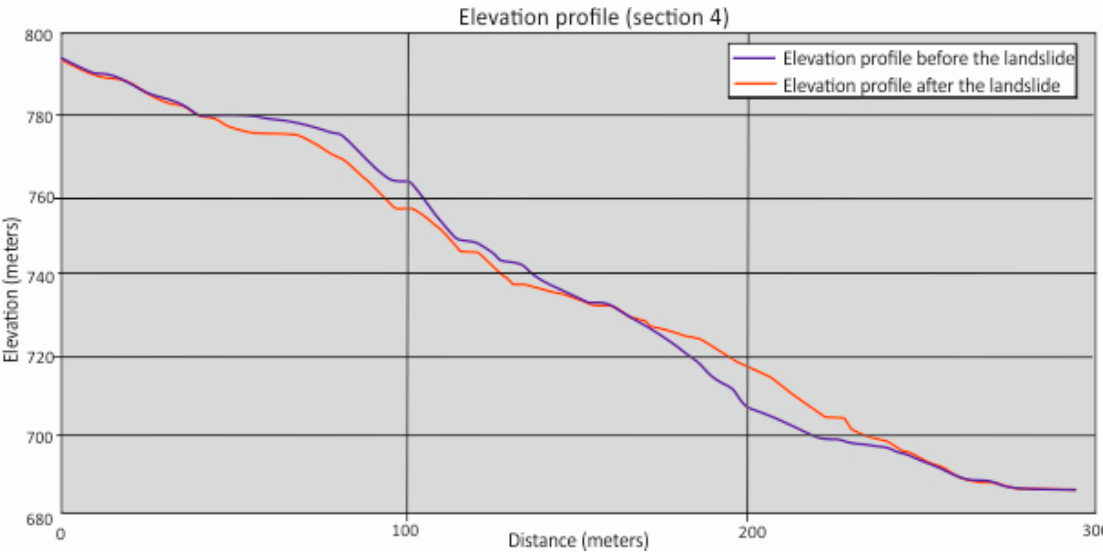
Figure 12. Elevation profiles of section 3 in Figure 11.